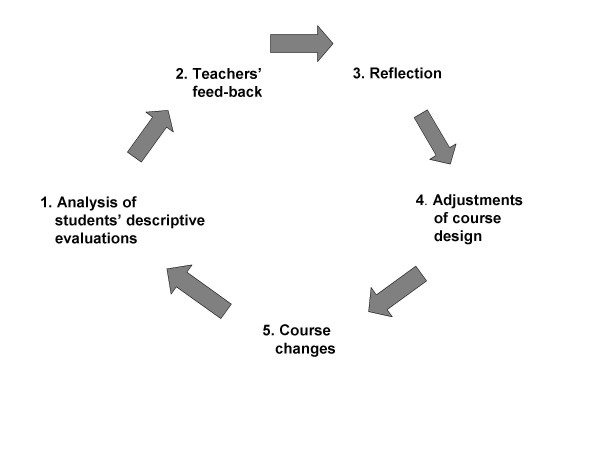
Evaluation cycle in course development. Evaluation cycle of teachers' systematic course evaluation and development. Consultation skills course, Medical faculty, Göteborg university.